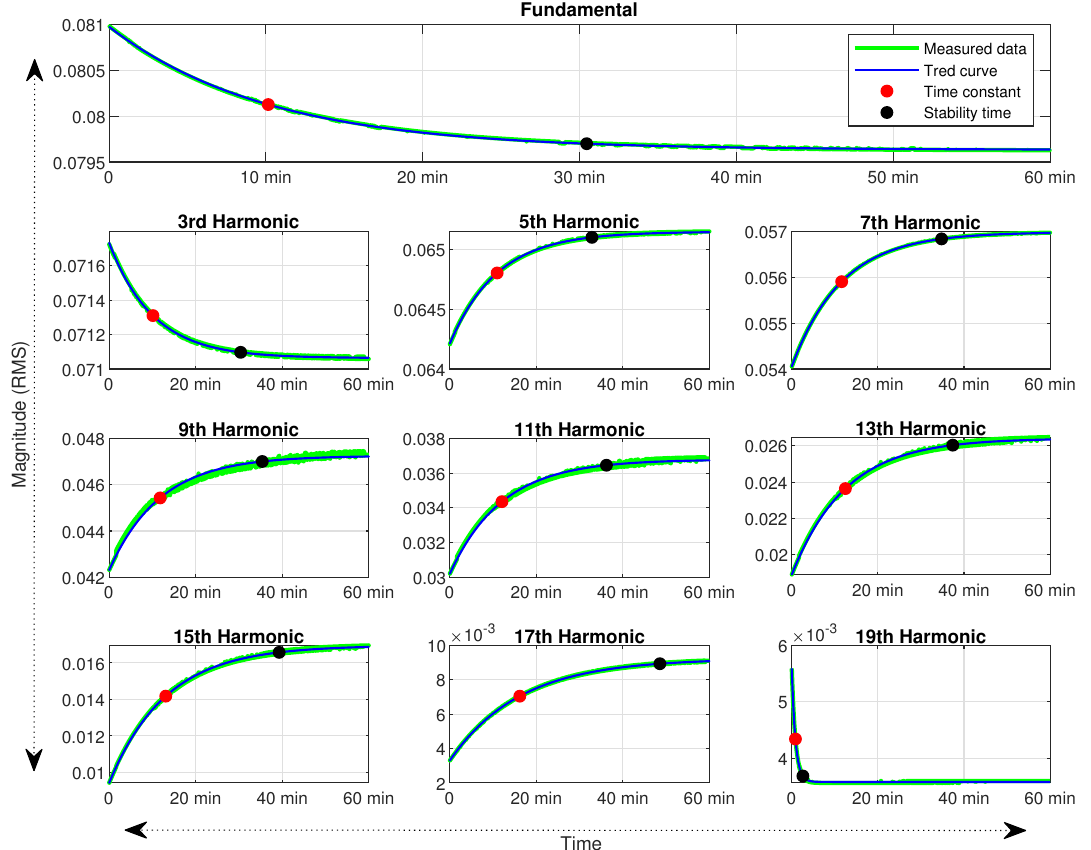
Figure 5. Current harmonic magnitude variation over time for power supply